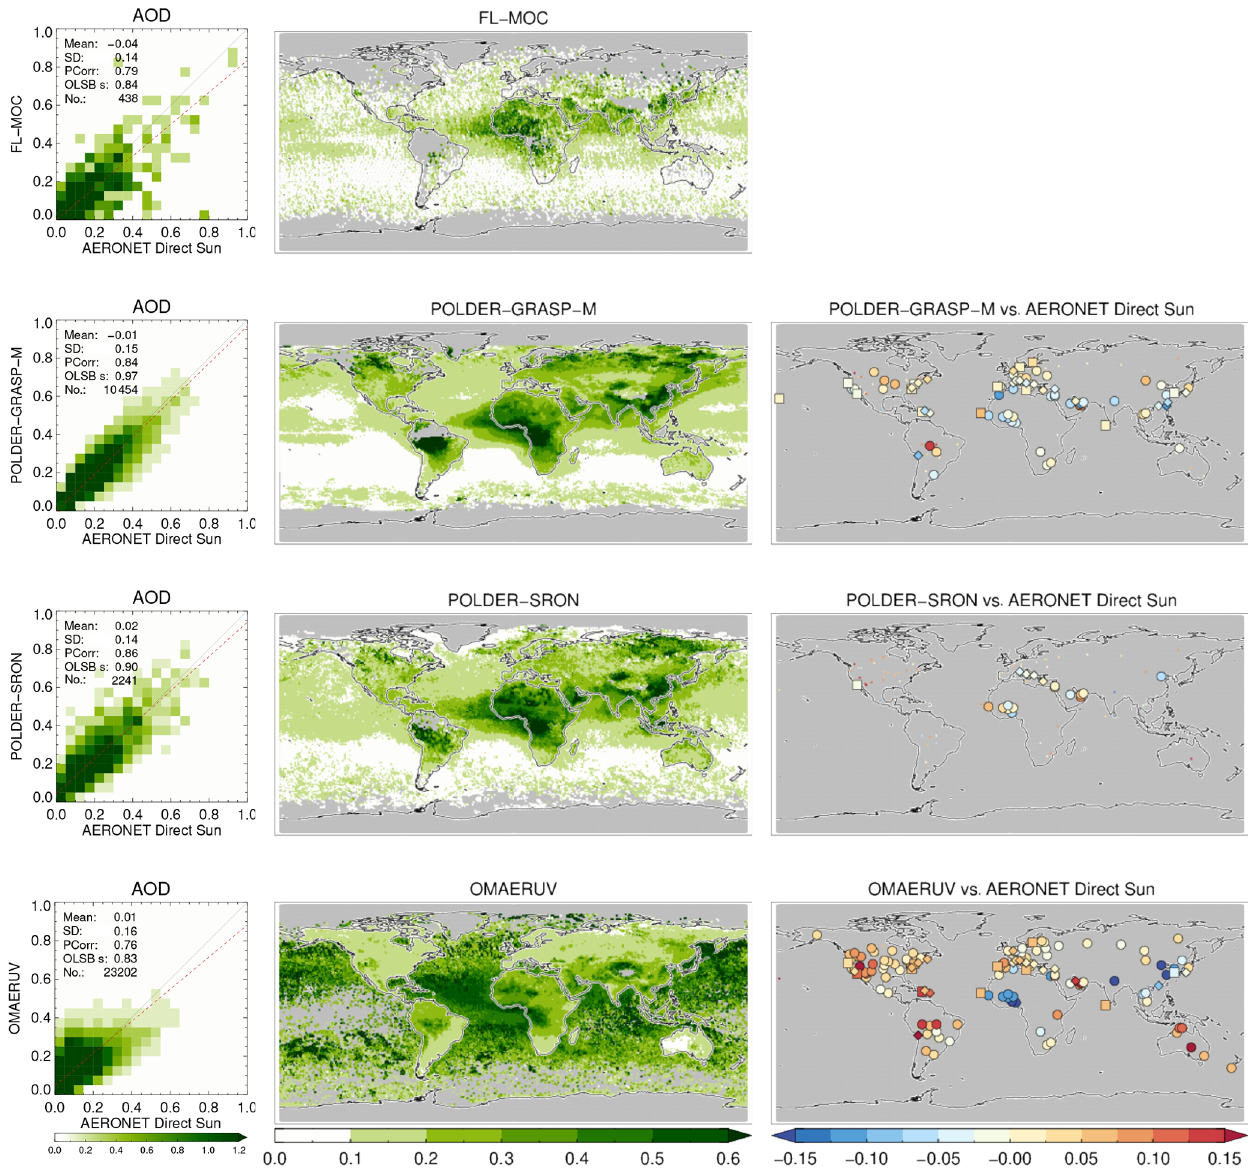
Figure 7. For the four satellite products the following are shown: a scatter plot of individual super-observations versus AERONET (the colour indicates amount of data in percentages; see Sect. 3.3 for an explanation of the metrics), a global map of the 3-year AOD average and a global map of the 3-year AOD difference average with AERONET (if the site provided at least 32 observations; land sites are circles, ocean sites are squares, and diamonds are the remainder). For FL-MOC, insufficient data prevent the plotting of a difference map. Products were individually collocated with AERONET DirectSun L2.0 within